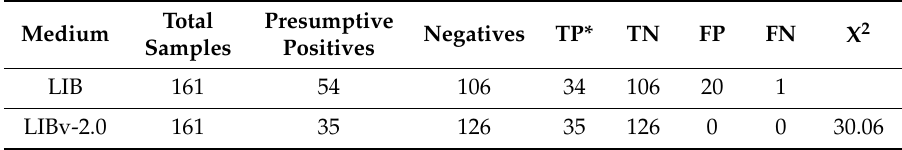
Table 1. Field Trial